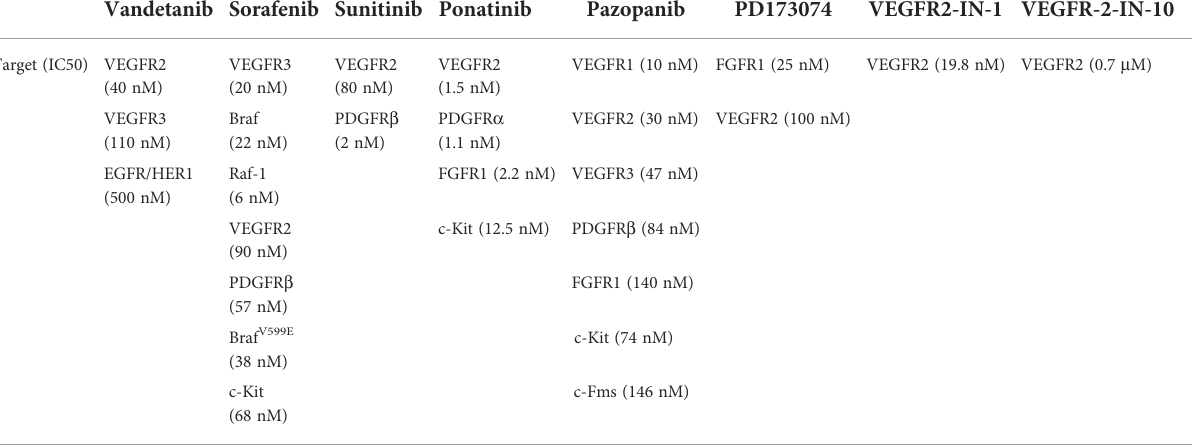
TABLE 2 Speci fi c targets of Protein Tyrosine Kinase/RTK drugs acting on VEGFR. Vandetanib Sorafenib Sunitinib Ponatinib